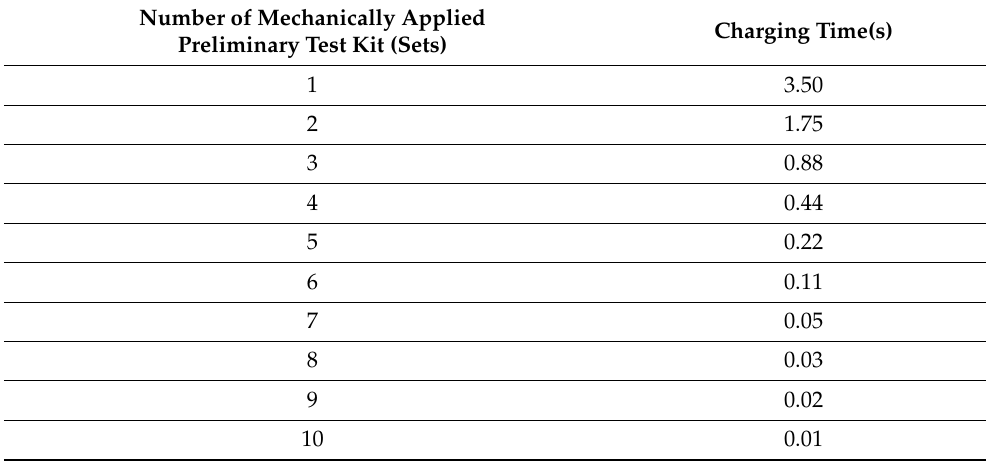
Table 2. Charging time needed for a preliminary test kit to generate energy when subjected to mechanical force.